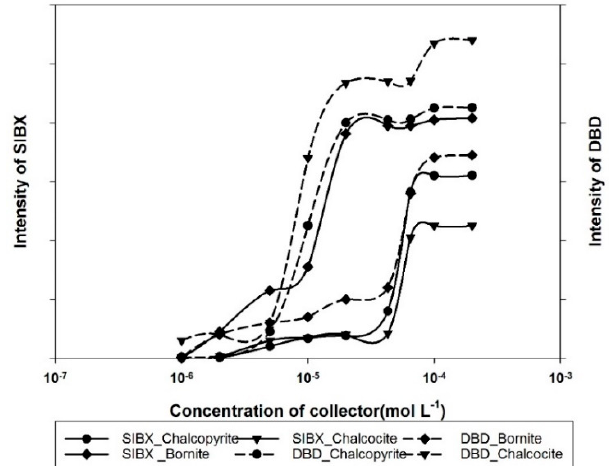
Figure 14. The intensities of characteristic SIBX and DBD bands for chalcopyrite, chalcocite and bornite.